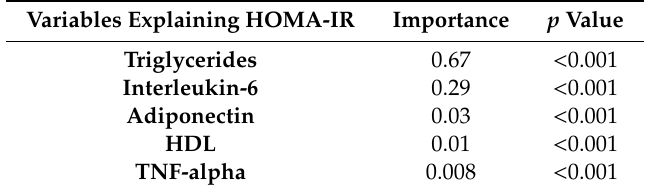
Table 3. Variables explaining HOMA-IR by generalized linear model.